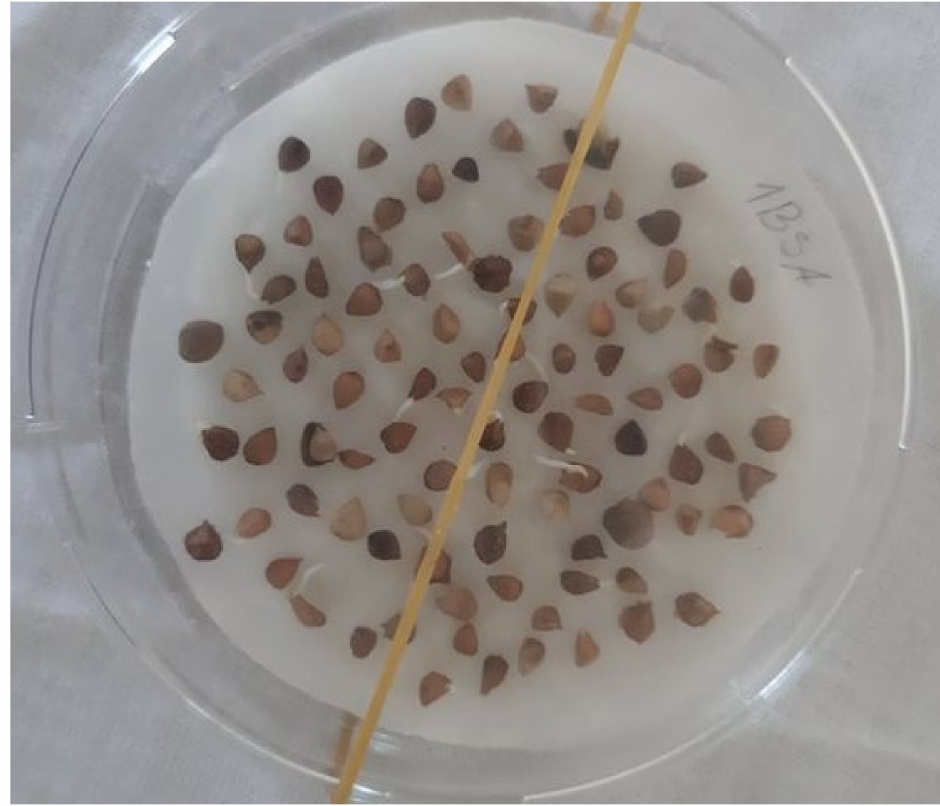
Figure 11. Petri dish with seeds of Boswellia socotrana subsp. aspleniifolia , some of them